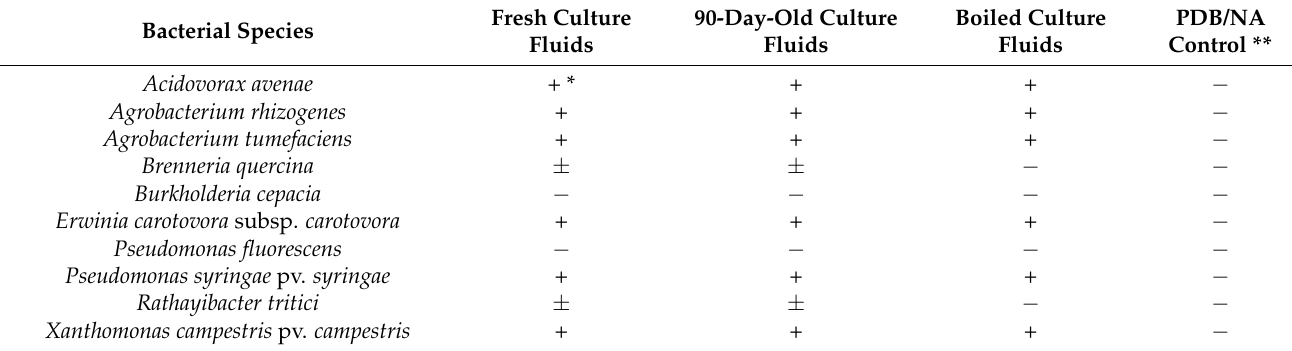
Table 1. Stability of antibacterial activity of filter-sterilized potato dextrose broth culture fluids from G. lucidum by long term storage or boiling for one hour when compared to freshly harvested culture fluids. Bacterial